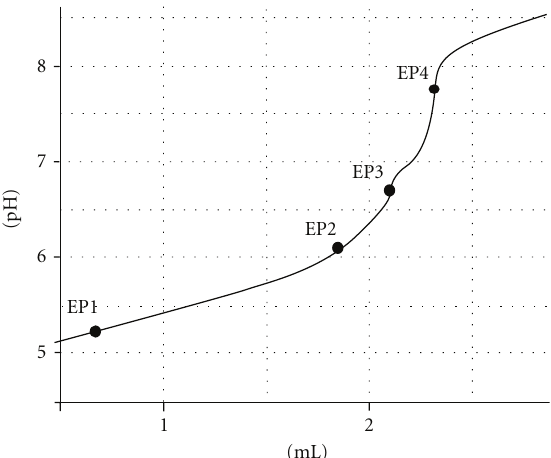
Figure 6: The titration curve of a hot water wood